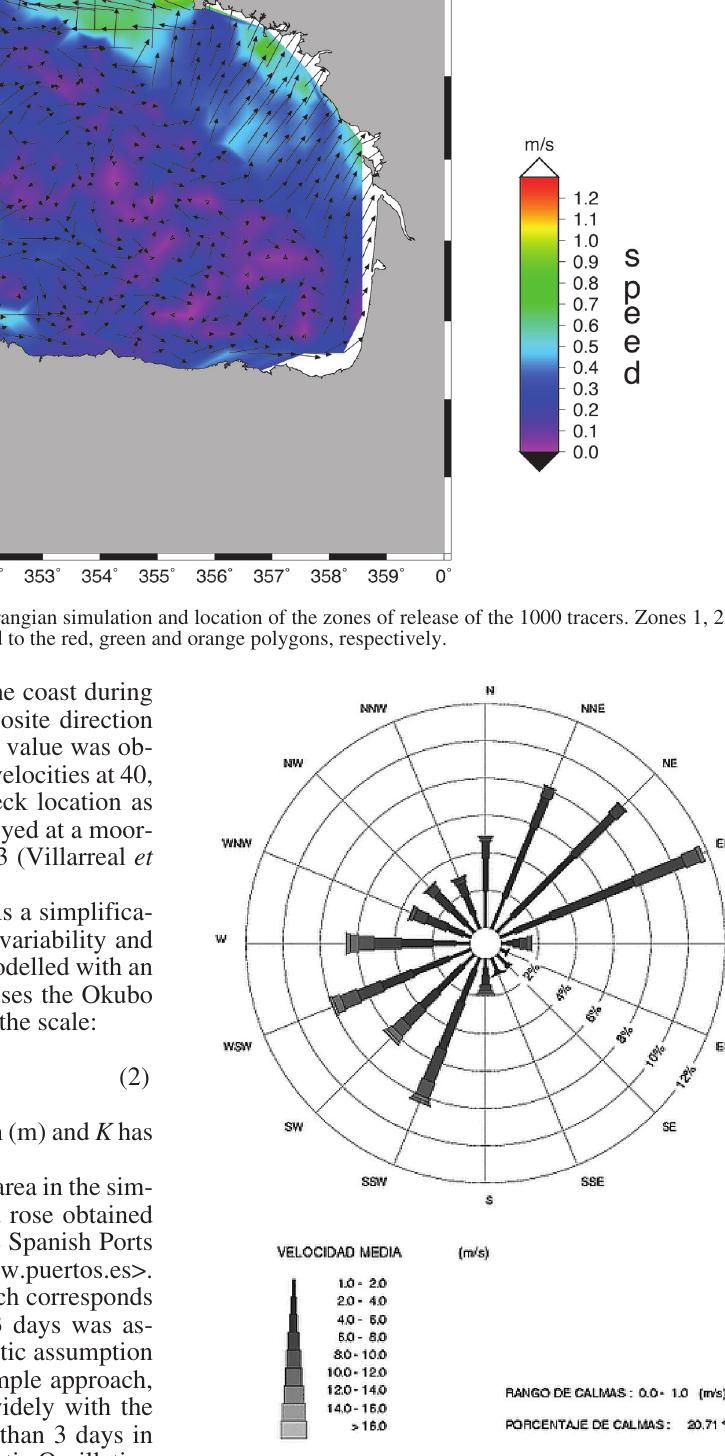
Fig . 6. – Wind Rose for the mean wind velocity at the El Ferrol coast in 2004. Obtained from the Puertos del Estado web page (www.puertos.es) in the menu “Oceanografía y